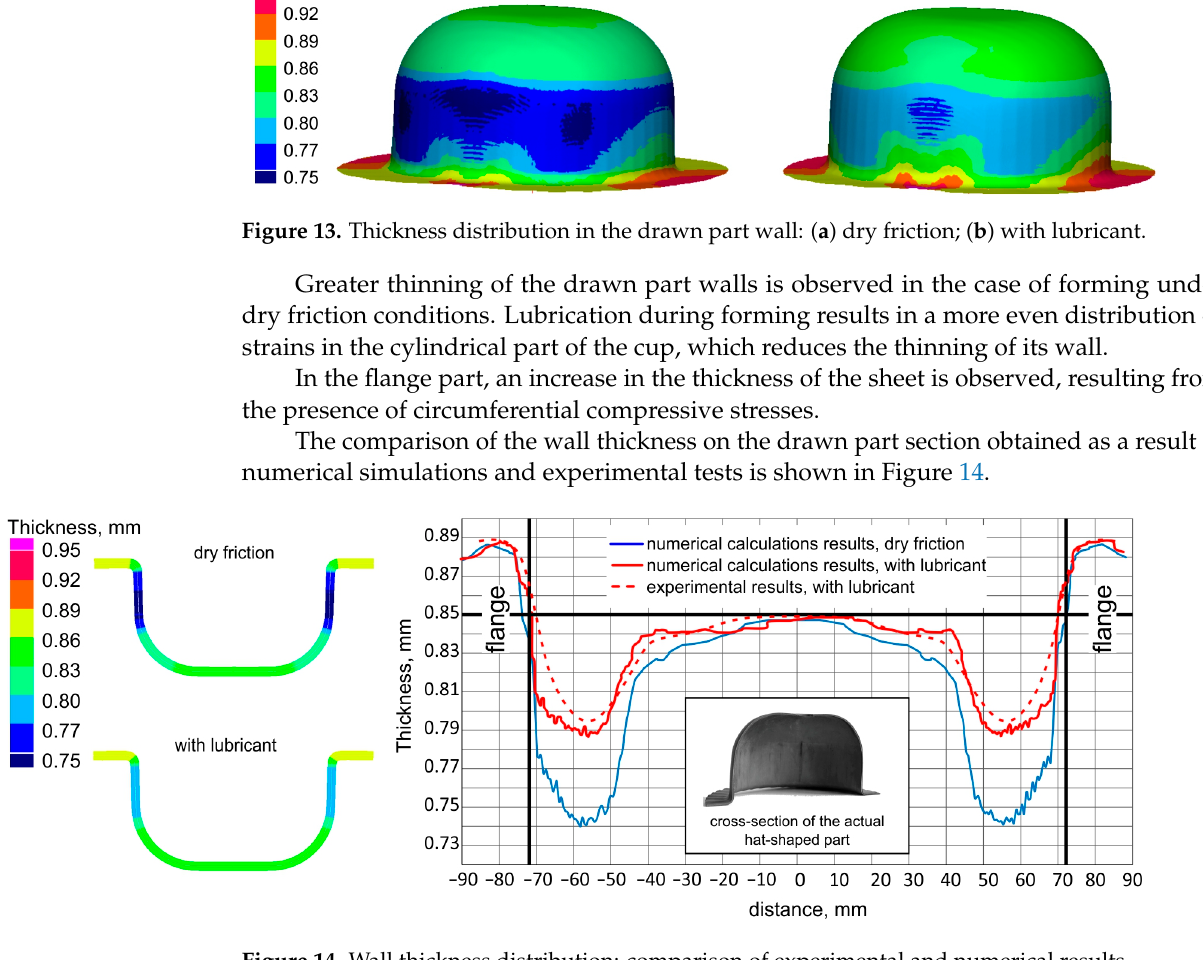
14 of 18 Figure 12. Evaluation of the deep drawing process using the forming limit diagram (zones by qual- ity): ( a ) 1st variant of forming with dry friction; ( b ) 2nd variant of forming with lubrication.